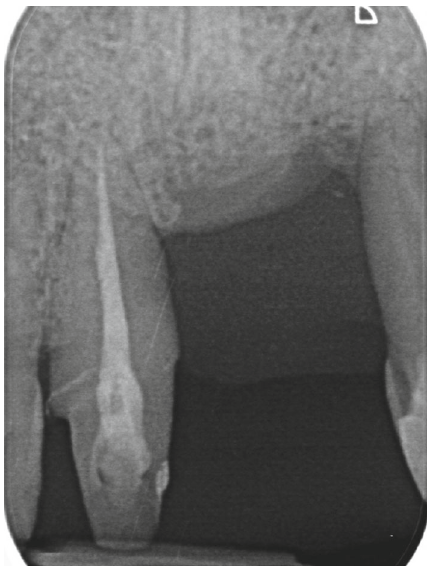
Figure 20: Final intraoral periapical